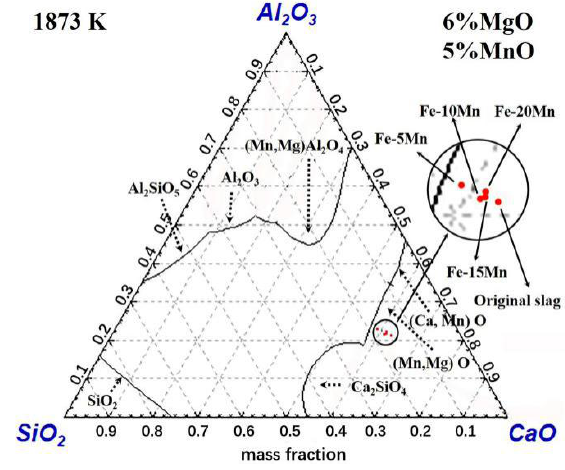
Figure 2. Change in slag compositions before and after slag–steel reaction.